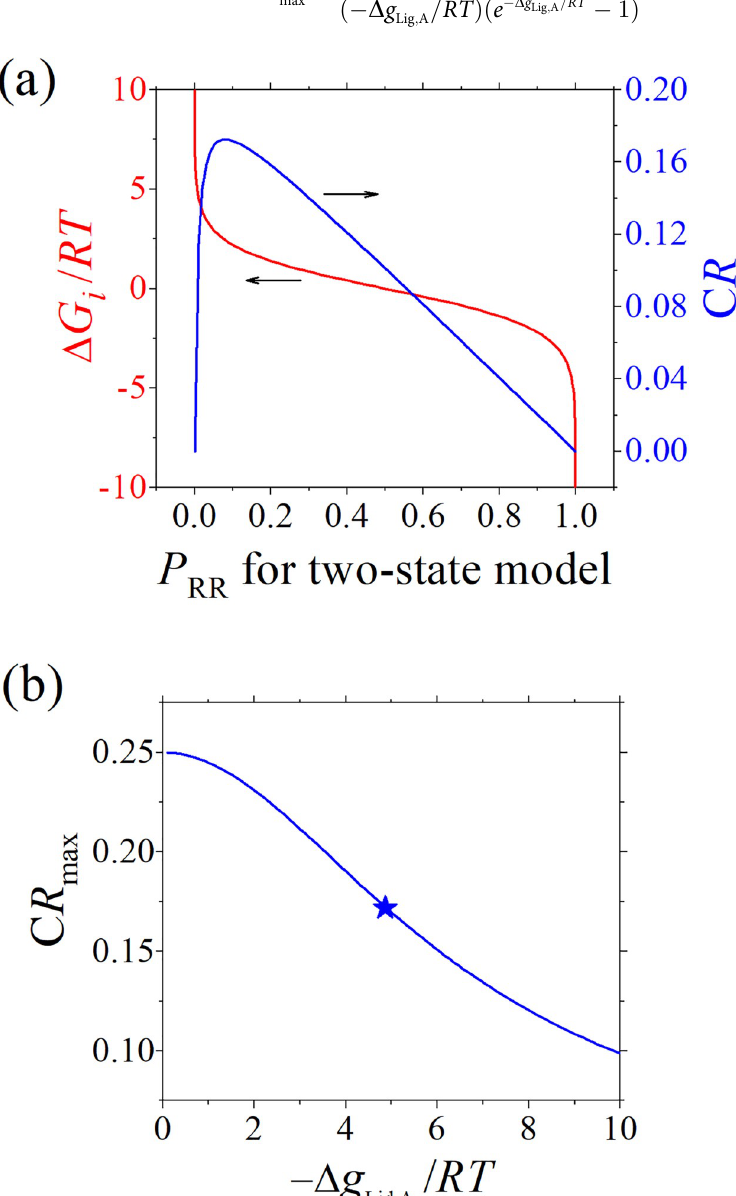
Fig 5. Limits of CR. (a) The relations among P RR , Δ G and CR for the MWC model with two states, plotted according i to Eqs 8 and 9. (b) The CR maximum (via optimizing state stabilities of proteins) as a function of − Δ g Lig,A / RT , plotted according to Eq (10) which is valid for the comprehensive ensemble model as well as the MWC and EAM models. The star represents the data point for Δ g Lig,A = − 3 kcal/mol and T = 310.15 K used in other